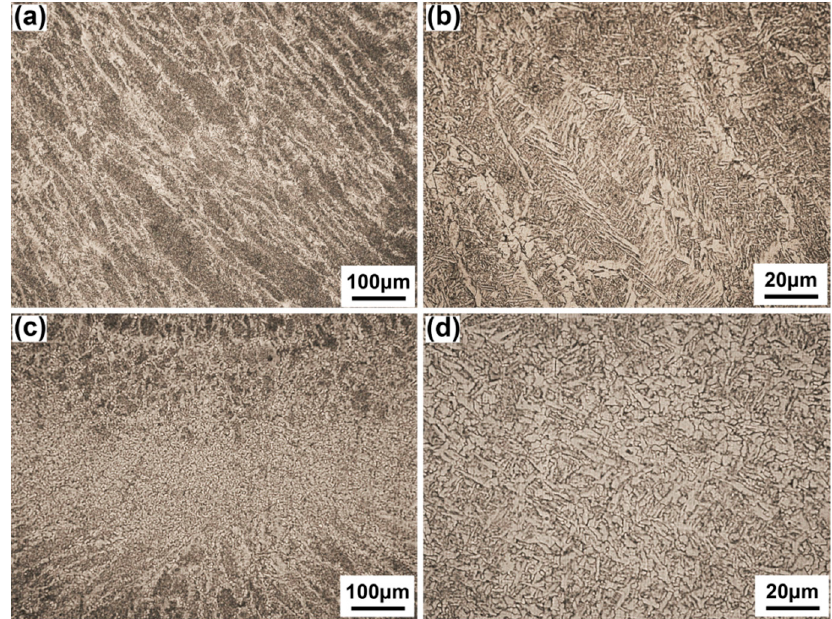
Figure 5. Microstructure of filler layer and overlapped interlayer, ( a ) filler layer; ( b ) amplified picture of ( a ); ( c ) overlapped interlayer; ( d ) amplified picture of ( c ).